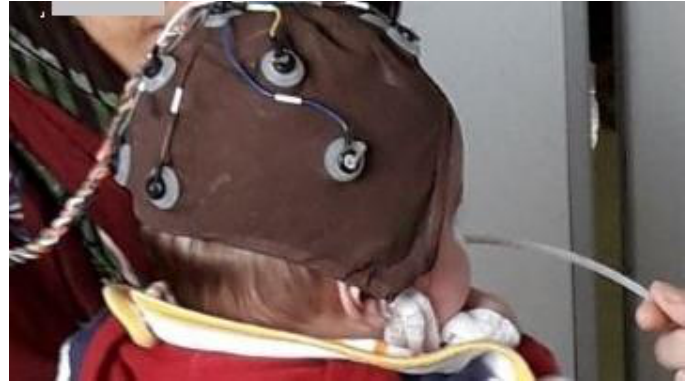
Figure 3. Example of an olfactory stimulation during an OERP recording session in an infant. The displayed OERP registration was carried out within the INSPIRE Lab (Vito Fazzi Hospital-Lecce,